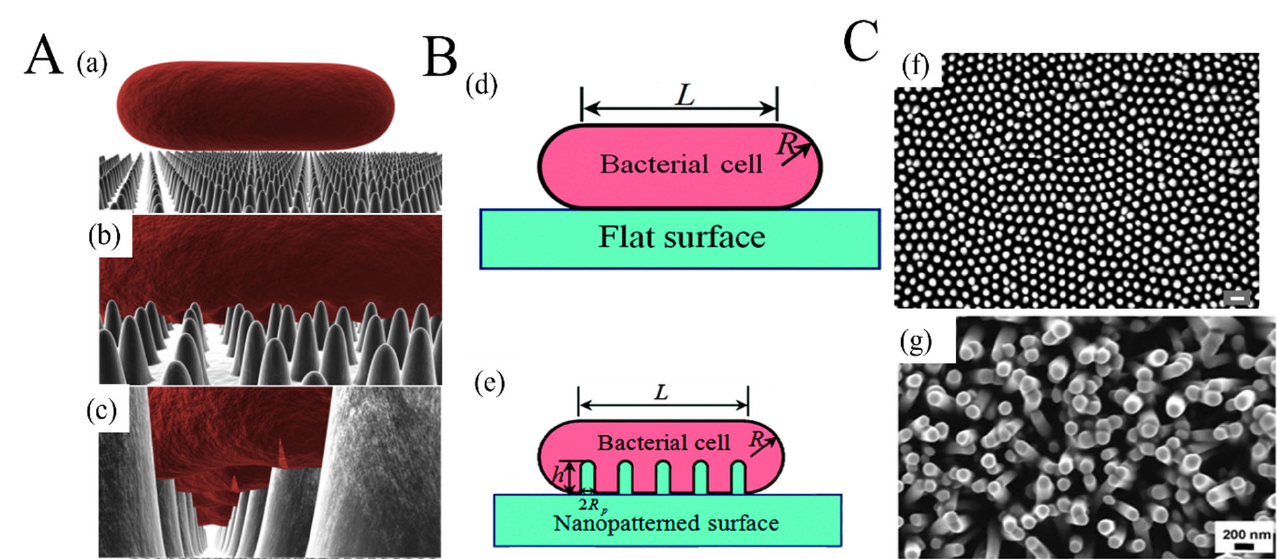
Figure 4. The rupture of bacterial cell walls by physicomechanical mechanisms: ( A ) Three-dimensional (3D) illustration of the interactions between a rod-shaped cell and the surface on which the nanorods grow vertically—( a ) the contact between the cell and the surface; ( b ) the absorption of the cell onto the nanostructured surface; ( c ) the rupture of the cell membrane (( a – c ) are reprinted with permission from [117]). ( B ) Schematic illustration of a bacterial cell adhering to ( d ) a flat surface and ( e ) a nanopatterned surface (reprinted with permission from [118]). ( C ) Comparison of the surface of clanger cicada wings and ZnO nanorods—( f ) scanning electron micrograph (SEM) image of the surface of a cicada wing with (scale bar = 200 nm) (reprinted with permission from [117]); ( g ) SEM of the ZnO nanorods produced on polydimethylsiloxane by a hydrothermal method (reprinted with permission from [113]).